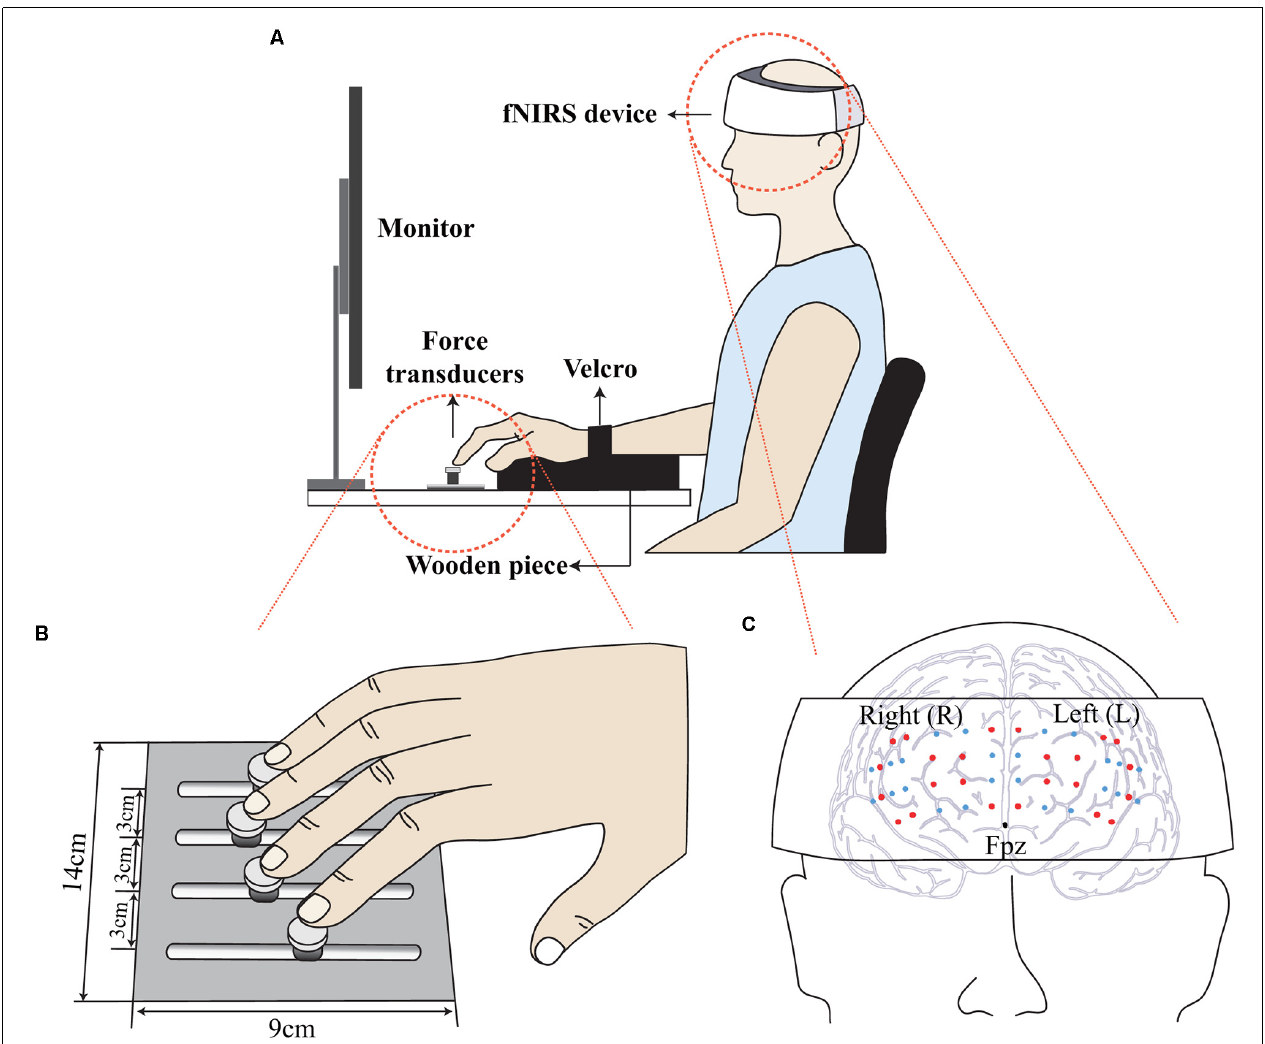
FIGURE 1 | Illustration of the experimental setup. Participants wore a wearable fNIRS device, and the computer screen visualized the real-time force and the force template. The participant’s wrist was held stationary with Velcro straps while a wooden cylinder supported the palm (A) . Four force transducers were attached to a frame (B) . A wearable fNIRS device located just above the nasion (Fpz), and the probes (small dots) were firmly contacted on the prefrontal region (C)